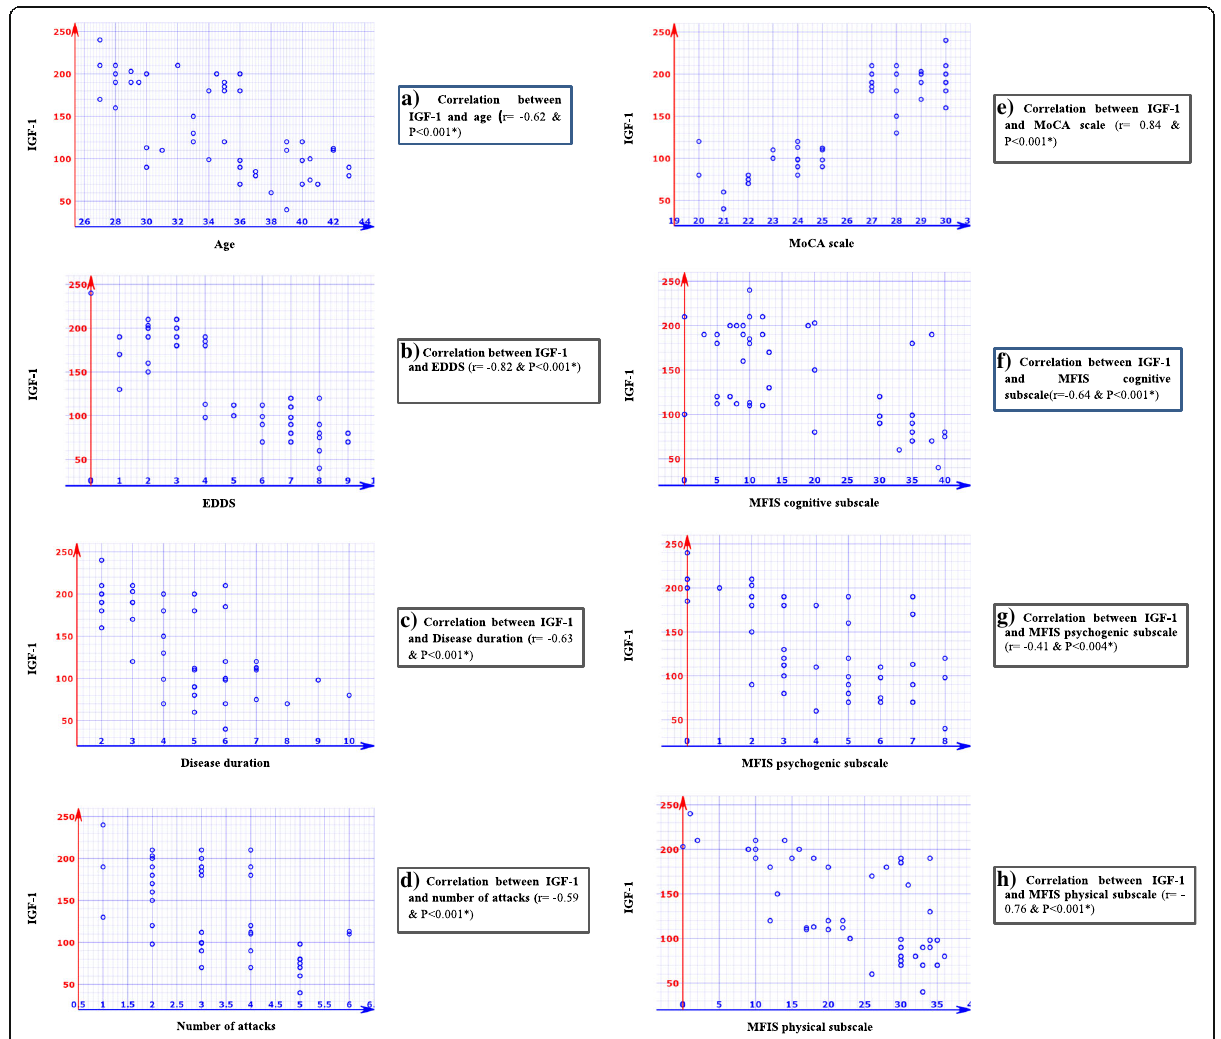
Fig. 1 Correlation coefficient of variables with serum levels of IGF-1 in MS